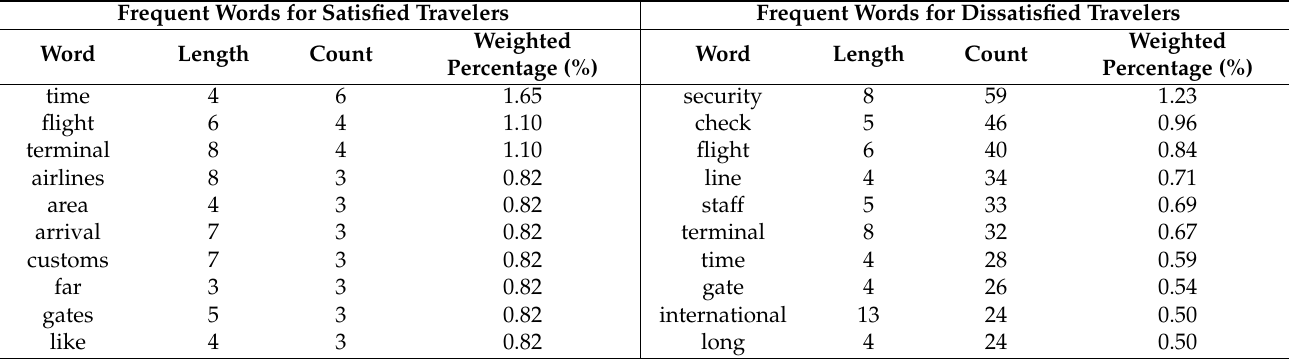
Table 3. Frequently Occurring Words for the Honolulu International